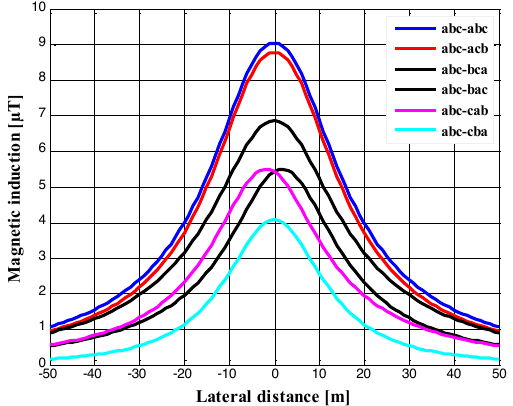
Figure 18: Comparison of magnetic induction in different phase’s arrangement for double circuit vertical line (500 A).